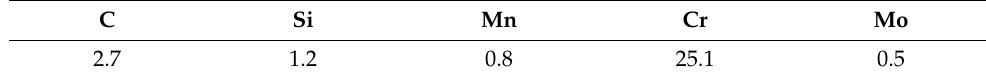
Table 1. Chemical composition (%